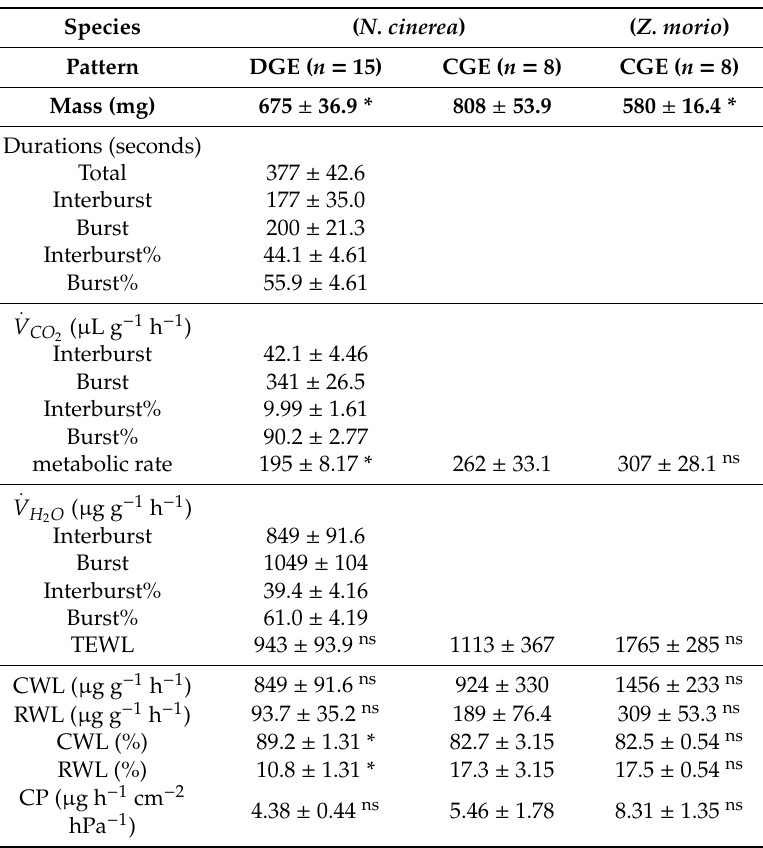
Table 1. Gas exchange characteristics of cockroaches showing DGE and CGE and beetles showing CGE at an average temperature of 23 ◦ C and at a flow rate of 25 mL min − 1